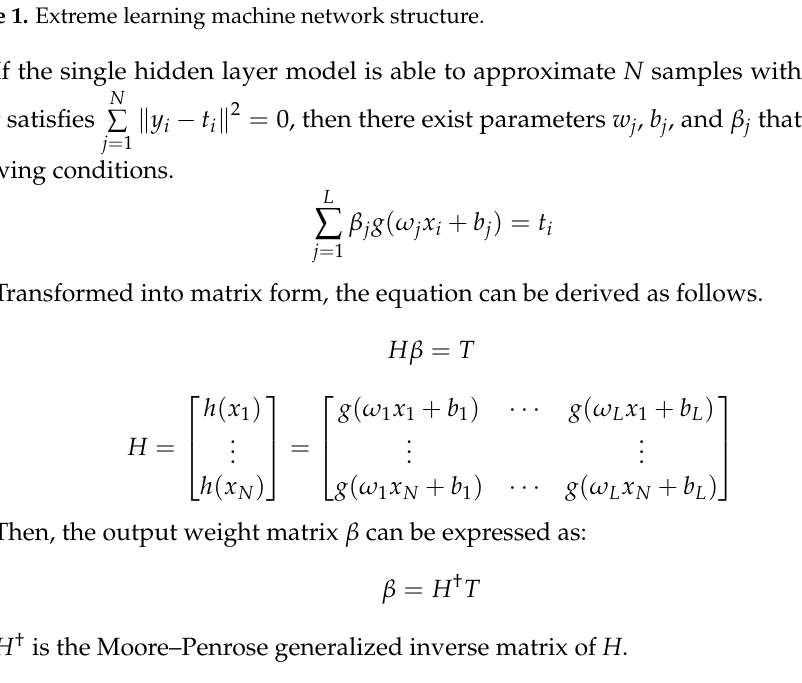
Figure 2. The social hierarchy of the grey wolves.